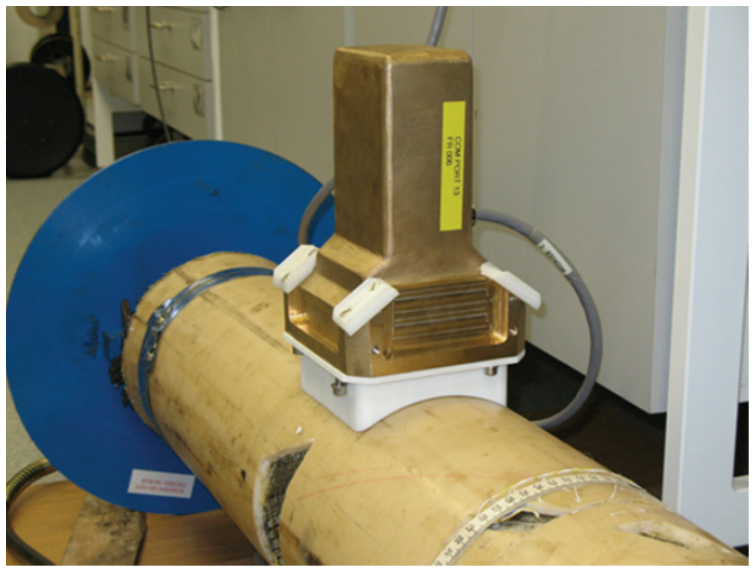
Figure 5. The MAPS-FR probe on a pipe sample (Reprinted/adapted with permission from Ref. [132]. Copyright year: 2010, copyright owner’s name: Springer Nature).